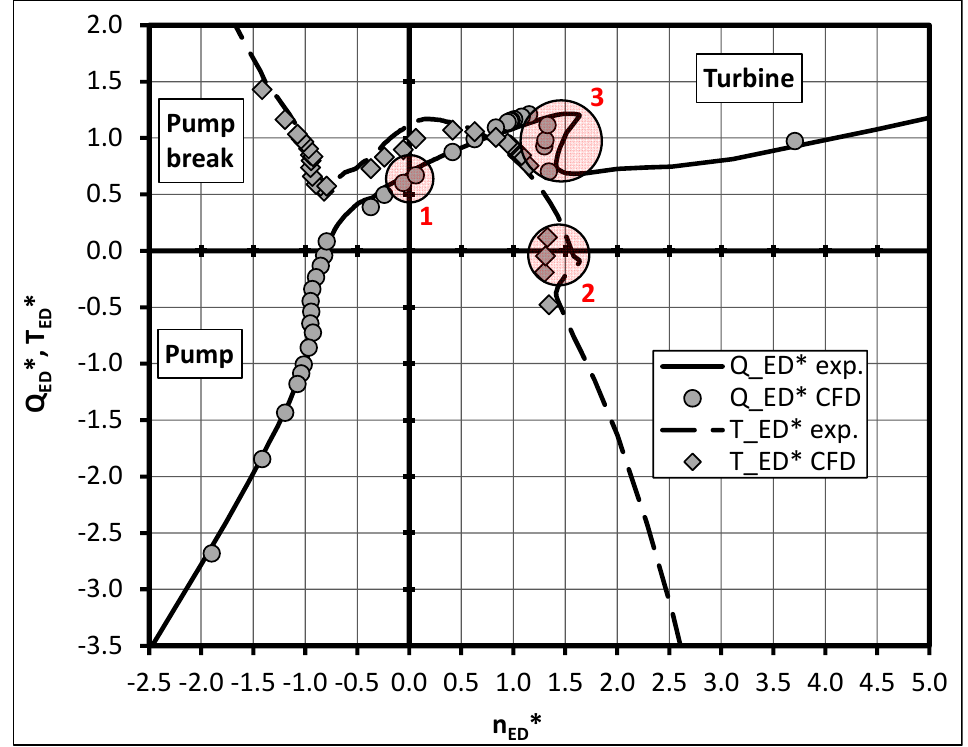
Figure 10. Four-quadrant curves: numerical (markers) and experimental data (lines); variable pitch pump 0° blade position.